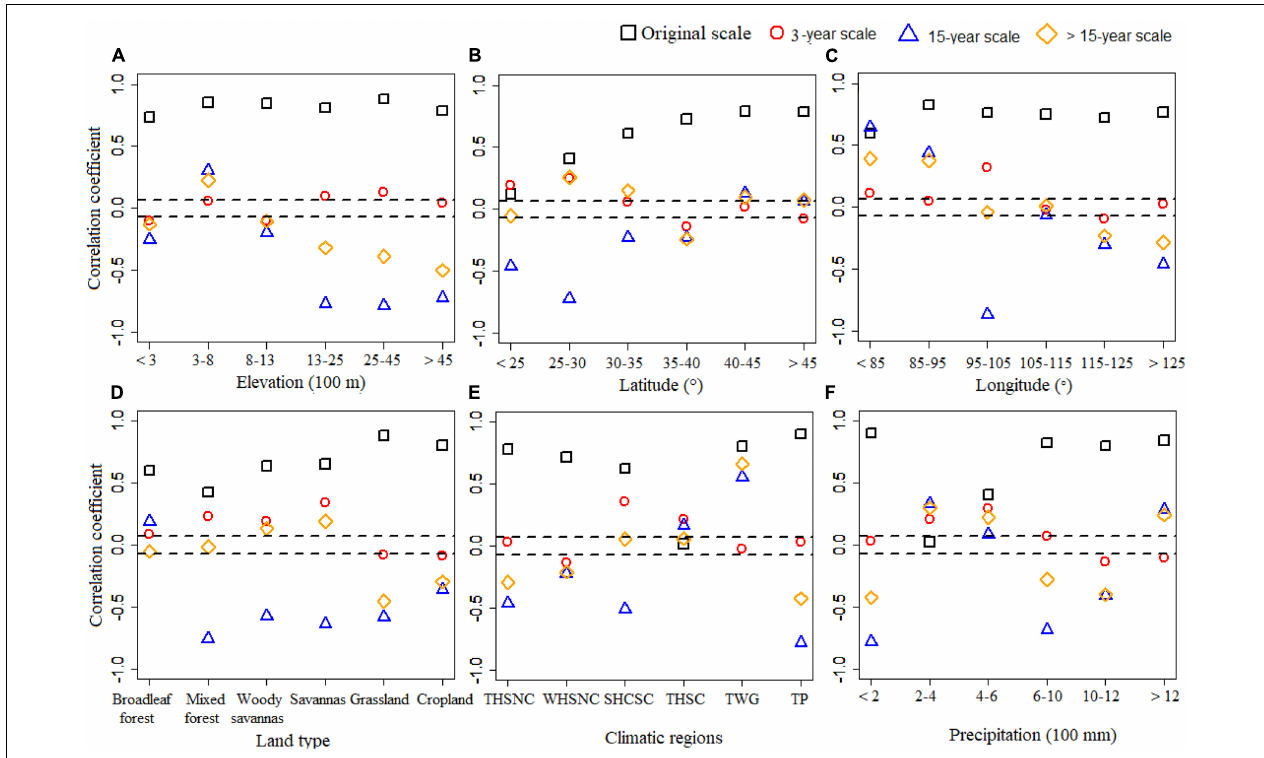
FIGURE 6 | Temporal correlation between NDVI and accumulated precipitation (AP) under different (A) elevation, (B) latitude, (C) longitude, (D) land type, (E) climatic regions, and (F) precipitation at the original scale and multiple temporal scales. NDVI, normalized difference vegetation index.